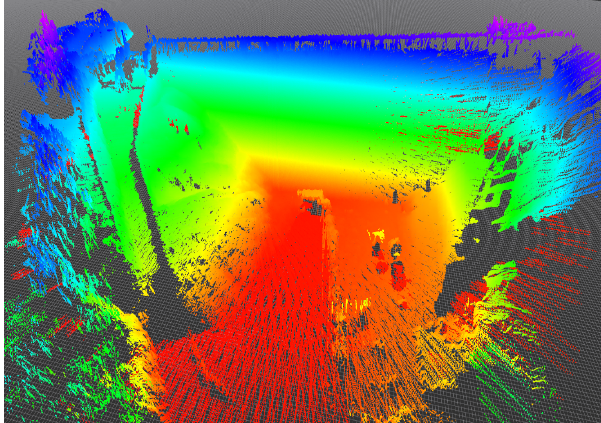
Figure 15. Map of the Guerledan dam generated by LOAM process on rotation payload